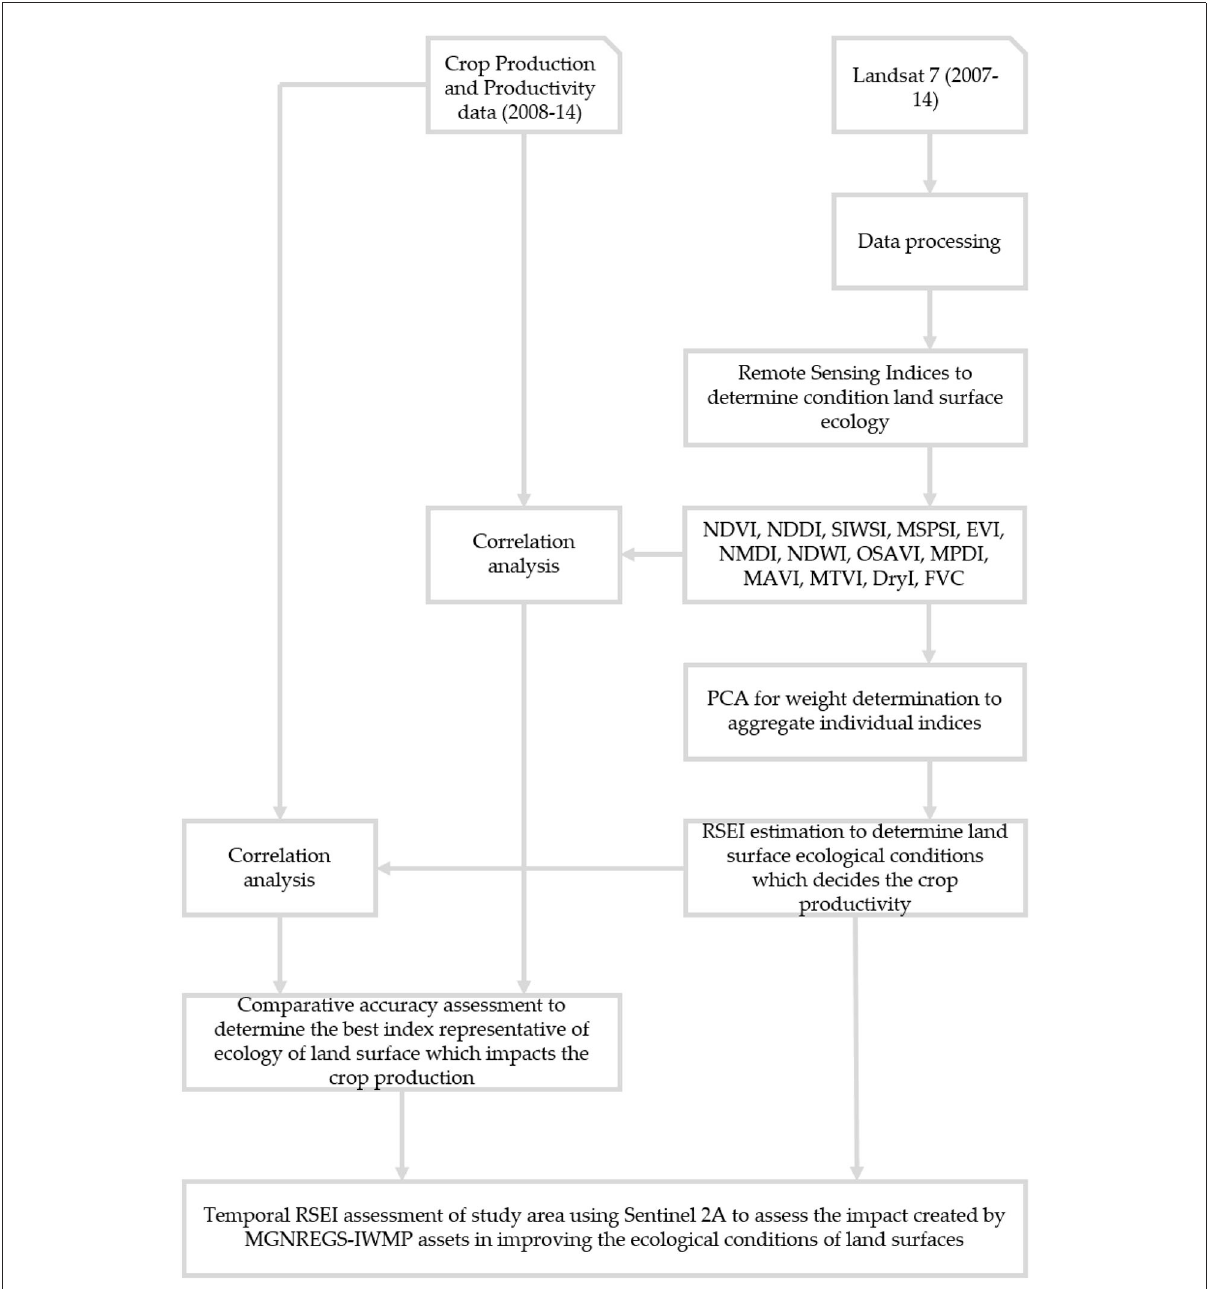
FIGURE2 Framework and methodology of